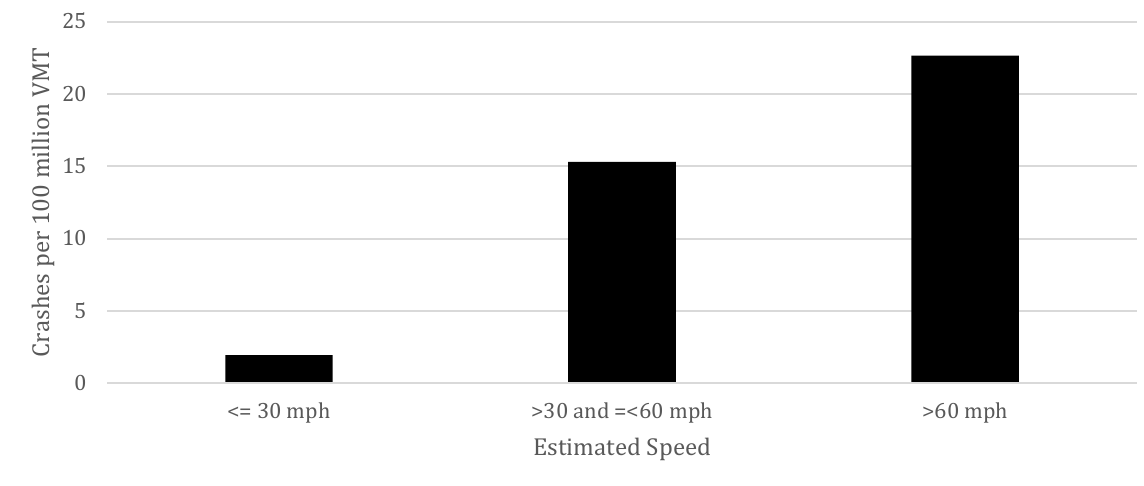
Figure 6 (a): Rate of animal-vehicle crashes based on estimated vehicle speed